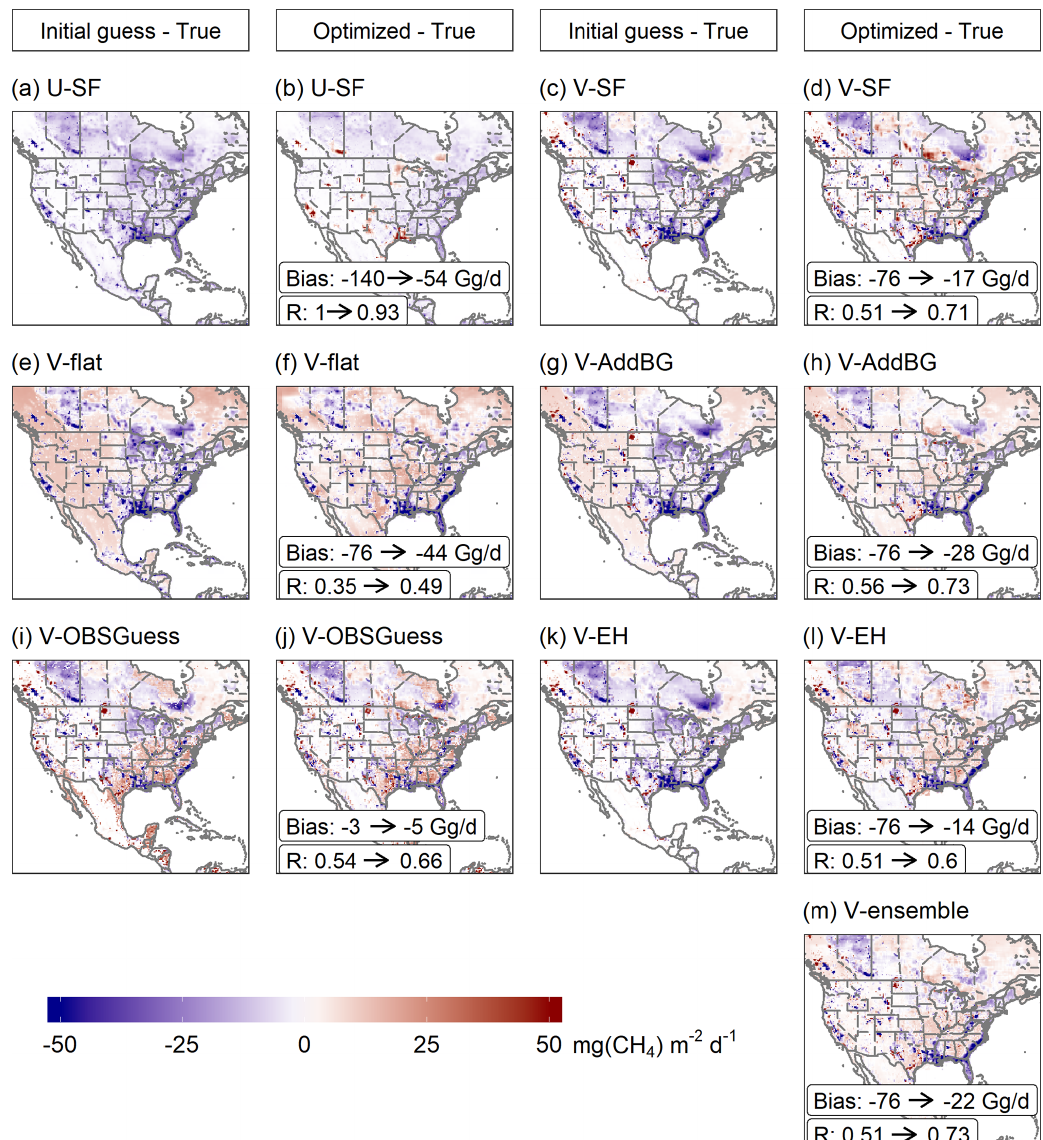
Figure 4. Differences between the initial-guess emissions and the true state and between the optimized emissions and the true state, for each inversion framework. Labels inset indicate the change in domain-wide bias and spatial correlation with respect to the true fluxes achieved through each optimization. More details are provided in Table 1 (inversion specifications) and Fig. S4 (initial-guess and optimized emissions). Inversions shown here do not include model transport errors; Fig. S7 shows results when such errors are included.